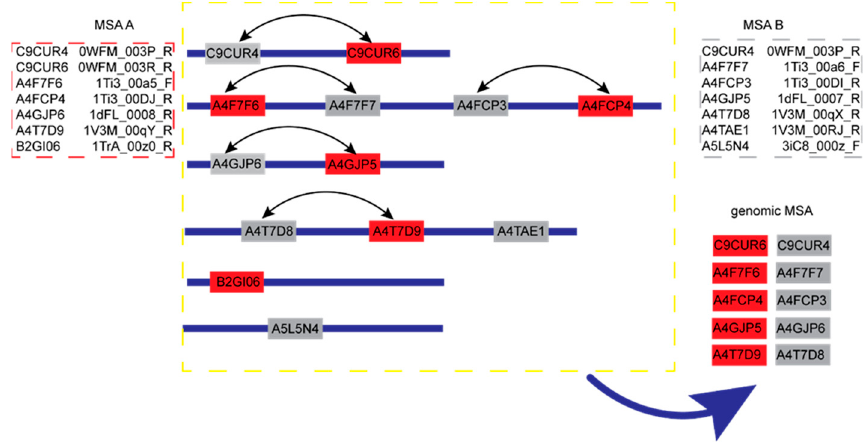
Figure 5. An example of the genomic-based MSA concatenation.